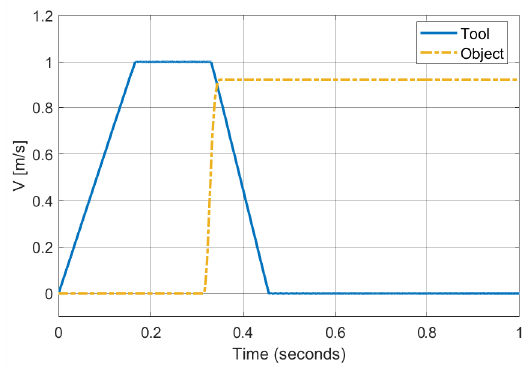
Figure 25. Tool rigidly connected to the rigid robot with e = 0.1, k c = 10 3 N m p = 0.25